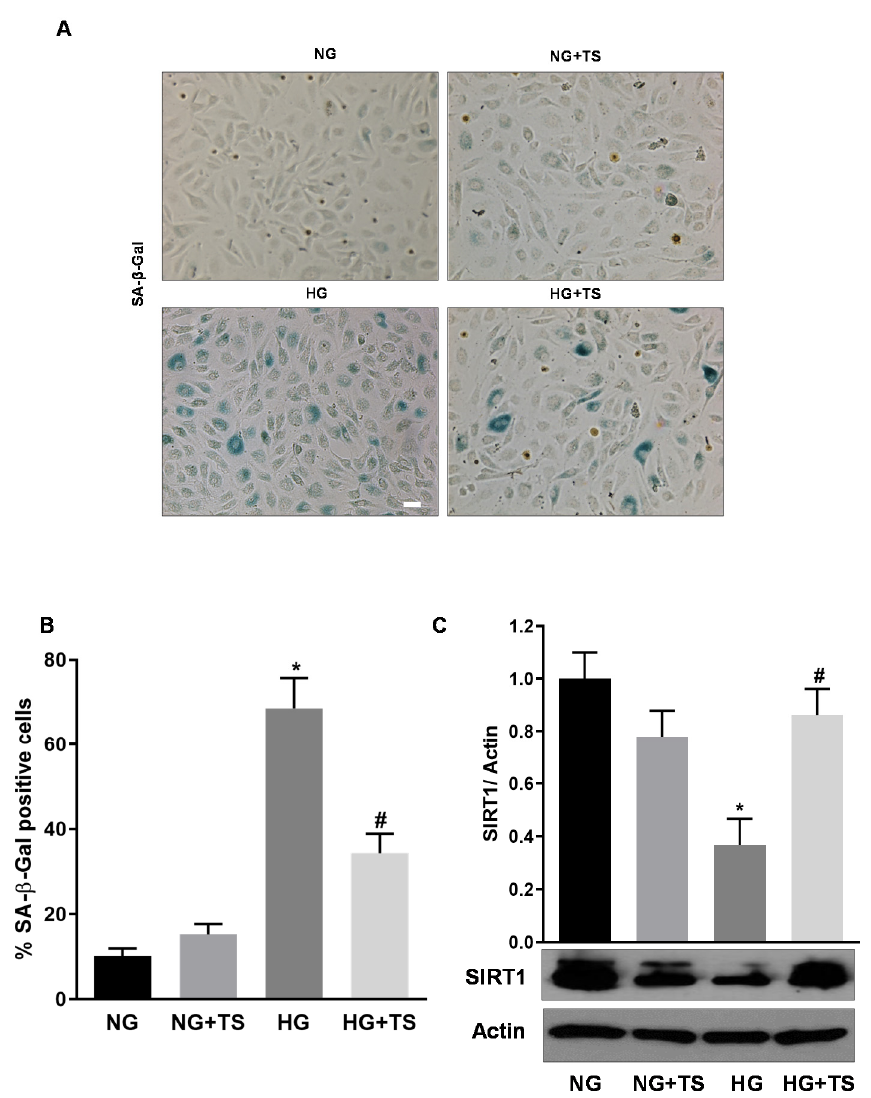
Figure 10. Tubastatin A e ff ects on HG-induced senescence markers in HuREC. ( A ) Representative images of senescence-associated β -Galactosidase (SA- β -Gal) reactivity assay in HuREC exposed to HG for 48 h or HG plus 5 µ M of TS (HG + TS), also for 48 h, and compared to HuREC cultured in NG conditions in the absence (NG) or presence of 5 µ M TS (NG + TS). Positive cells develop the blue color. Scale bar, 50 µ m. ( B ) Quantification of SA- β -Gal-positive cells. Values are number of positive cells per well versus total number of cells expressed as a percent. n = 3. * p < 0.001 vs. NG and # p < 0.001 vs. HG. ( C ) Western blotting analysis showing protein levels of the histone deacetylase SIRT1 in HuREC treated in the same experimental conditions as described in ( A ). Bar histograms represent optical density values of the blots normalized for the loading control actin. Values are mean ± SEM for n = 3. * p < 0.01 vs. NG and # p < 0.01 vs.